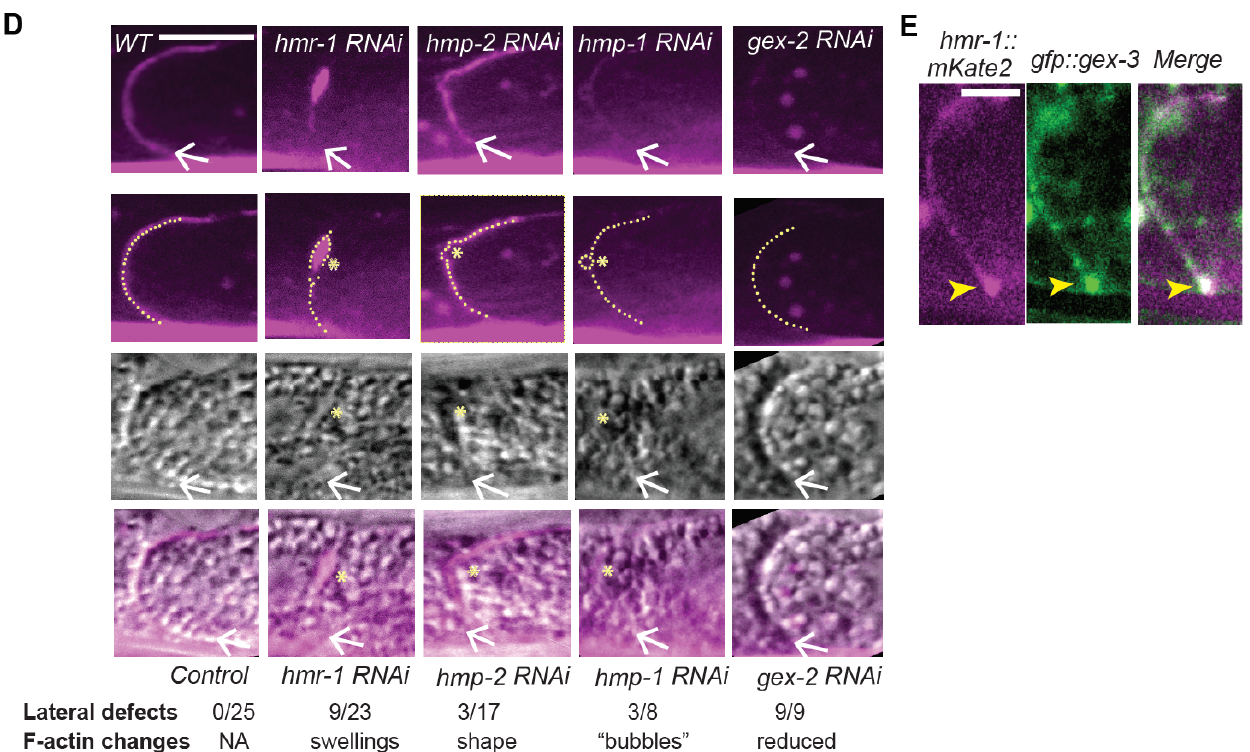
Figure 2. Cadherin complex and WAVE complex support apical F-actin. ( A ) Developmental expression of the new transgene, Pglo-1::Lifeact::TAG::RFP , built for this study. Expression begins in embryos and is enriched apically by the one-fold embryonic stage. It becomes increasing enriched apically, as shown in L4, the late larval stage used for most of this study, to young adults, one day older than L4. Brackets indicate the apical region of ring Int3, and the dotted lines indicate how apical lumen enrichment was measured in B. All scale bars shown are 5 μm long, except for panel ( E ). ( B ) Representative images of apical F-actin in intestinal ring 3 in L4 larvae in controls and in animals depleted by feeding RNAi of regulators of branched actin, or components of the apical junction. ( C ) Mean intensity of F-actin in Int3. A line scan of 80 pixels (7 μm) was used to measure the average F-actin enrichment at the apical lumen of ring Int3. Each data point represents one animal: 11 for control, 7 for gex-3 RNAi , 7 for gex-2 RNAi , 7 for hmr-1 RNAi , 9 for dlg-1 RNAi , 5 for hmp-1 RNAi , 12 for hmp-2 RNAi . ( D ) While most of the F-actin is found along the apical lumen (shown at bottom in ( D ) and ( E )), there is enrichment along the lateral membrane (white arrows), compared in controls, and in animals depleted of WAVE complex component gex-2 and Cadherin components. The frequency of lateral abnormalities (yellow asterisks) and F-actin changes is listed below each image. “bubbles” refers to vesicle-like enrichments at the lateral membrane in hmp-1 RNAi. “Reduced” refers to the very low lateral signal in gex-2 RNAi. The filled-in vesicles seen in the gex-2 RNAi image are likely lysosomes, which tend to take up mCherry fluorescence. The actual lateral membrane is so reduced it is almost invisible. ( E ) In embryonic intestines, WAVE components are enriched more apically than the Cadherin Junction components [1]. Here, two CRISPR strains were combined to compare endogenous enrichment of HMR-1::mKate2 and GFP::FLAG::GEX-3. Yellow arrow heads point to the apicolateral membrane. Scale bar in this panel is 2.5 μm. ** = p < 0.005, **** = p < 0.0005, ns = not significant.